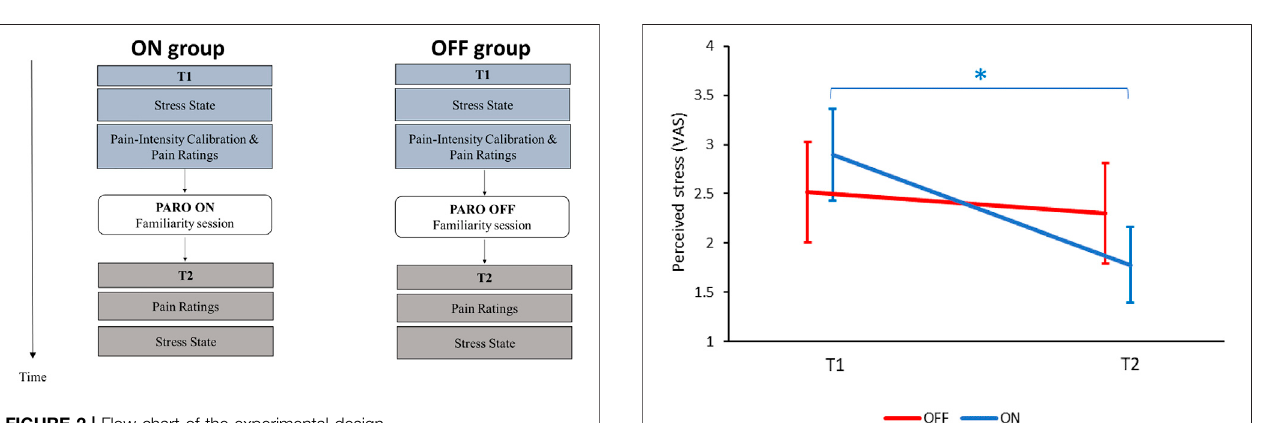
FIGURE 2 | Flow chart of the experimental design.